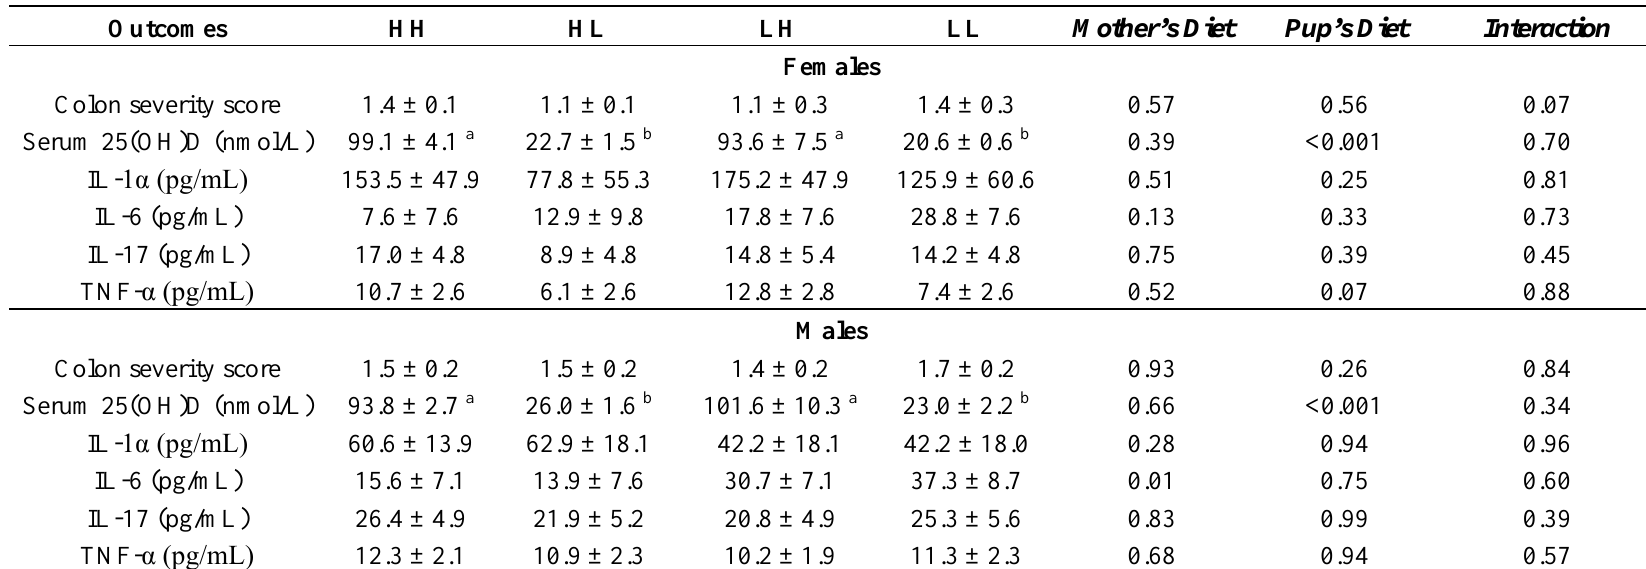
Table 3. Colon severity score, serum 25(OH)D and cytokines of offspring at three months of age. Mother’s Diet Pup’s Diet